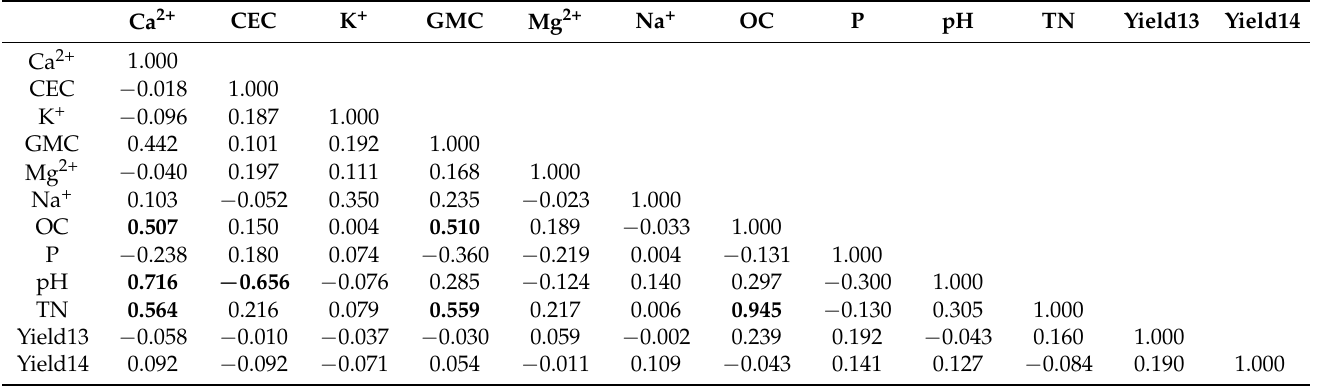
Table 3. Pearson correlations ( r ) between the soil properties and yields of 2013 and